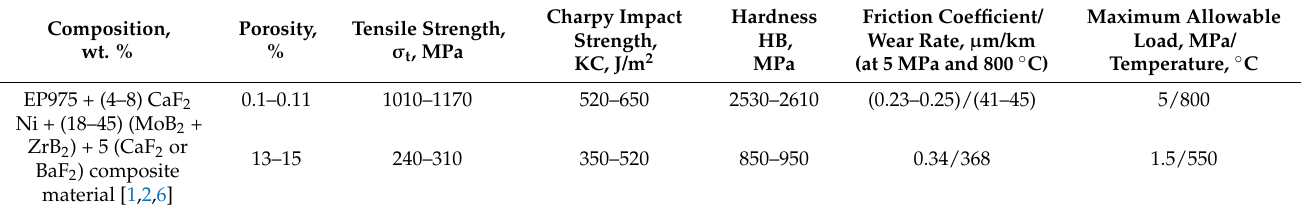
Table 6. Mechanical and Tribological Properties of the Materials.